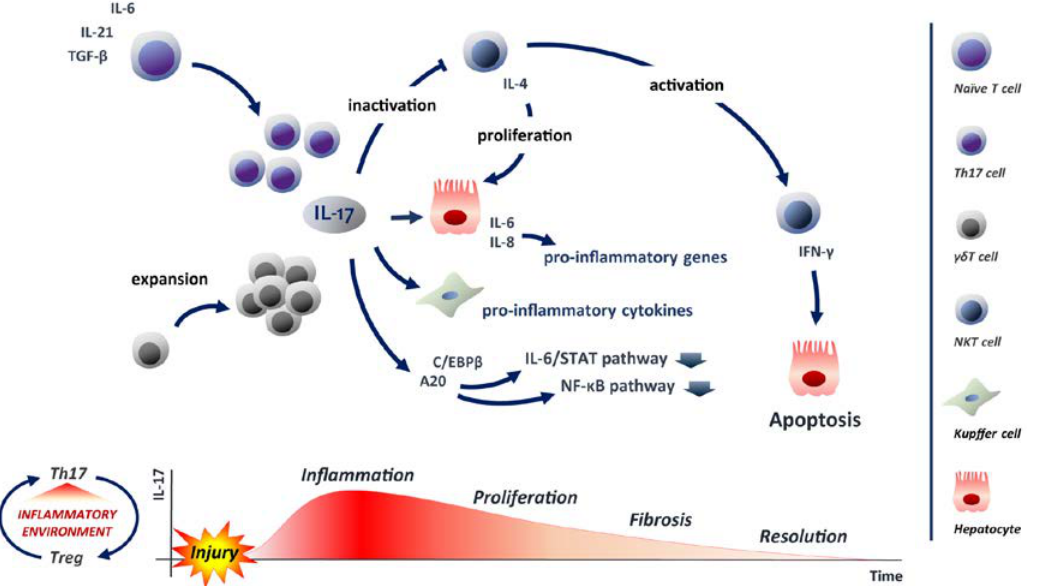
Figure 2. IL-17 impact in liver regeneration IL-17 is mainly produced by Th17 - from naïve T cells differentiation upon TGF- β , IL-6 and IL-21 stimulation - and γδ T cells. Inflammatory environment induced by injury sustains Th17 population and controls the balance between Th17 and their coun- teracting Treg cells to preserve immune homeostasis. Upon injury γδ T cells increase in number to sustain IL-17 levels. IL-17 acts on hepatocyte inducing massive production of IL-6 and IL-8 to trigger pro-inflammatory genes activation. IL-17 induced Kupffer cells produce pro-inflammatory cytokines. IL-17 signalling controls C/EBP β and A20 regulating in turn IL-6/STAT3 and NF- κ B signalling. In proliferating environment high level of IL-17 interferes with NKs activation inducing IL-4-mediated proliferation; reduced IL-17 levels at termination phase promote IFN- γ production by NKs reactivation, inducing apoptosis in hepatocytes and interrupting regenerating process.